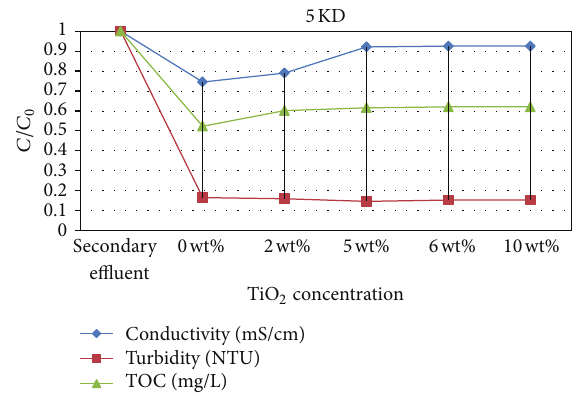
Figure 12: Permeate quality when treated with different TiO 2 con- centrations (5KD).